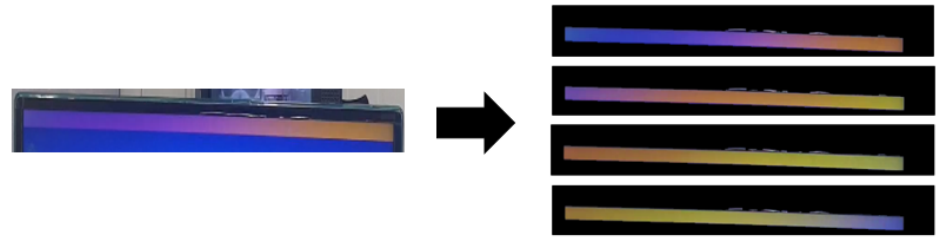
Figure 7. Four different patterns for received color barcode symbol 001 (R, G, B = 255, 191.5, 0).